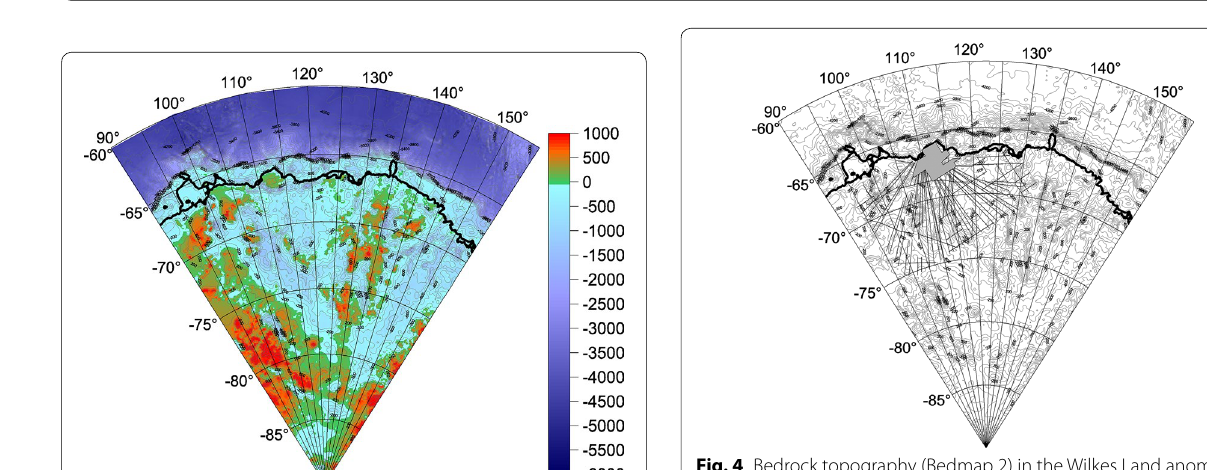
Fig. 4 Bedrock topography (Bedmap 2) in the Wilkes Land anomaly area. This black and white version of Fig. 3 shows a fan with high density of measurements along the tracks—the lines—with measuring airplane instruments and empty space in